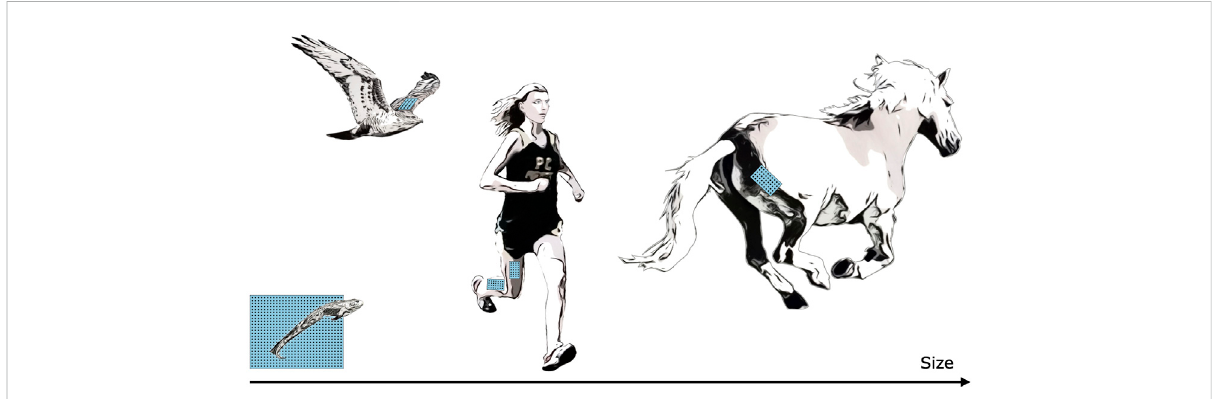
FIGURE 6 MuscleTrackingAcrossScales.Bychangingthesizeofthemagnetic fi eldsensingarray,wecantrackthedistancebetweenmagnetsatcloseror farther distances, allowing us in principle to track muscle tissues at a range of scales, including frogs, hawks, persons, horses, or other animals. For small animals, such as the frog shown at bottom left, a fi xed array below or beside the animal could track both the position of the animal and the muscle tissue